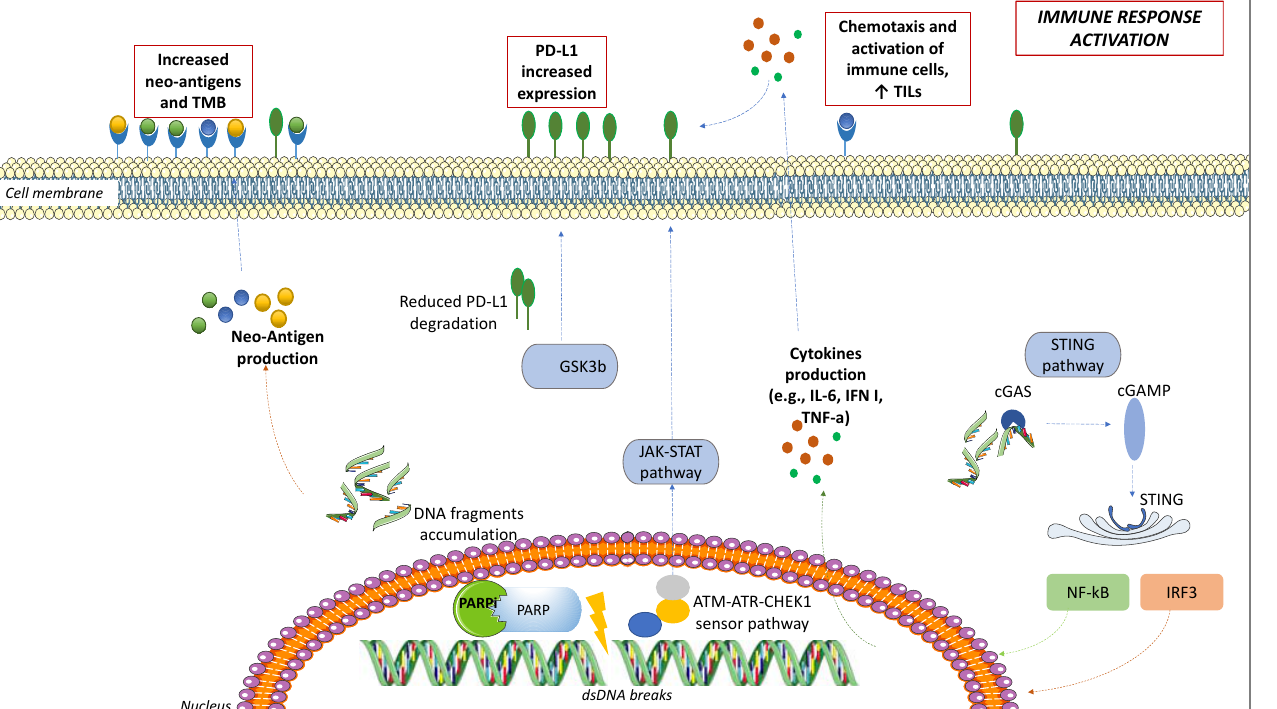
Figure 1. The interplay between PARP inhibitors (PARPis) and immune checkpoint inhibitors (ICIs). When double-strand DNA breaks (DSBs) occur and PARPis block PARP complex, DNA fragments accumulate in the cytoplasm. As a result, neo-antigens accumulate on the cell surface, where they are recognized by antigen-presenting cells (APCs), activating the immune response. Moreover, the Stimulator of interferon genes (STING) pathway is activated: DNA fragments are recognized by cytosolic sensor cGMP-AMP synthetase (cGAS), cGAS activates 2 ′ -5 ′ cyclic GMP-AMP (cGAMP), cGAMP switches on STING, STING modulates transcription factors such as Nuclear factor-kappa B (NF-kB), and Interferon regulatory factor 3 (IRF3), resulting in the transcription of related cytokines (Interferon [IFN], IL-6, tumor necrosis factor-alpha [TNF α ]), promoting immune response. IFN increases the expression of Programmed Death-Ligand 1 (PD-L1) on the cell surface. The activation of the sensor system Ataxia-Telangiectasia Mutated (ATM)-ATR Serine/Threonine Kinase (ATR)- Checkpoint kinase 1 (CHEK1) in case of DSBs, and the STAT-IRF pathway, increase PD-L1. Finally, DSBs inactivate glycogen synthase kinase 3-beta (GSK3 β ), responsible for PD-L1 proteasomal degradation, increasing PD-L1 cellular expression. These modifications result in a more immune responsive TME: increased surface neo-antigens, increased PD-L1 expression, cytokines, and chemotactic factors determine an increase in number and function of APCs, T-cells, NK cells, and decrease in immunosuppressive elements such as myeloid-derived suppressor cells and M2 macrophages. 4.2. Interactions between PARPis and TME TME plays a crucial role in the response to therapies. PARP and BRCA pathways interact with the TME, as they are involved in the correct development of T-cells, inflammatory and immune responses development, and expression and regulation of both soluble factors and cellular components within the TME [69–72]. Regarding T-cells, PARP2 seems involved in T-cell maturation, PARP1 regulates the differentiation of T- effectors versus Tregs through the expression of FoxP3, CD4 + differentiation, and TGF β expression, both PARP1 and 2 regulate T-cells function [73]. Regarding APCs, PARP1 has been involved in DCs recruitment and functioning, perhaps through the activation of the STING pathway in DCs [74,75]. These genes influence other cells in TME: PARP1 seems associated with macrophages polarization, and increased MDSCs have been found in BRCA1 mutant models [72,76]. Indeed, immune-suppressive elements such as MDSCs or TAMs are recruited at sites where continuous low-level DNA damage sustains a sort of